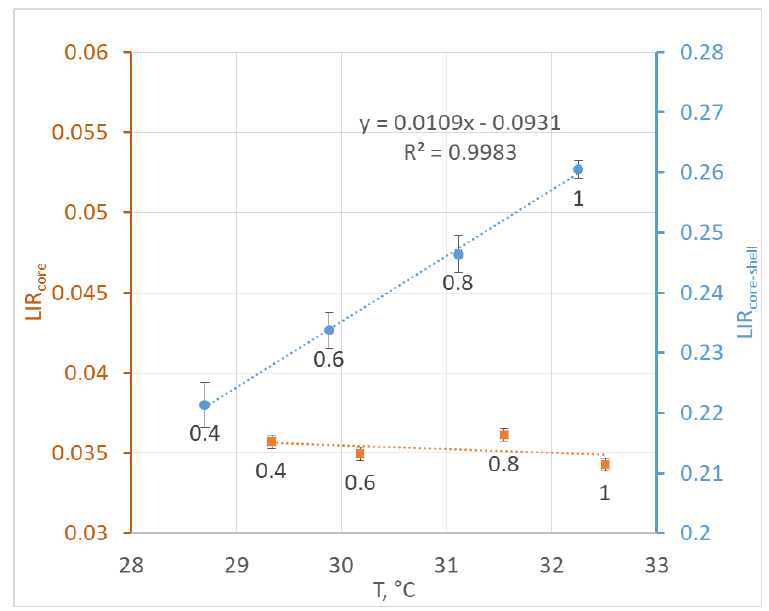
Figure 5. The dependence of luminescence intensity ratio (LIR) on the temperature for the core and core-shell nanoparticles in powder. The pump power density in W/cm 2 is shown as data labels.